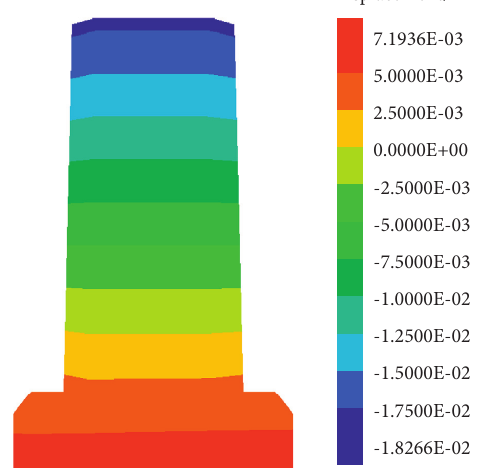
Figure 15: Cloud diagram of horizontal displacement of bridge